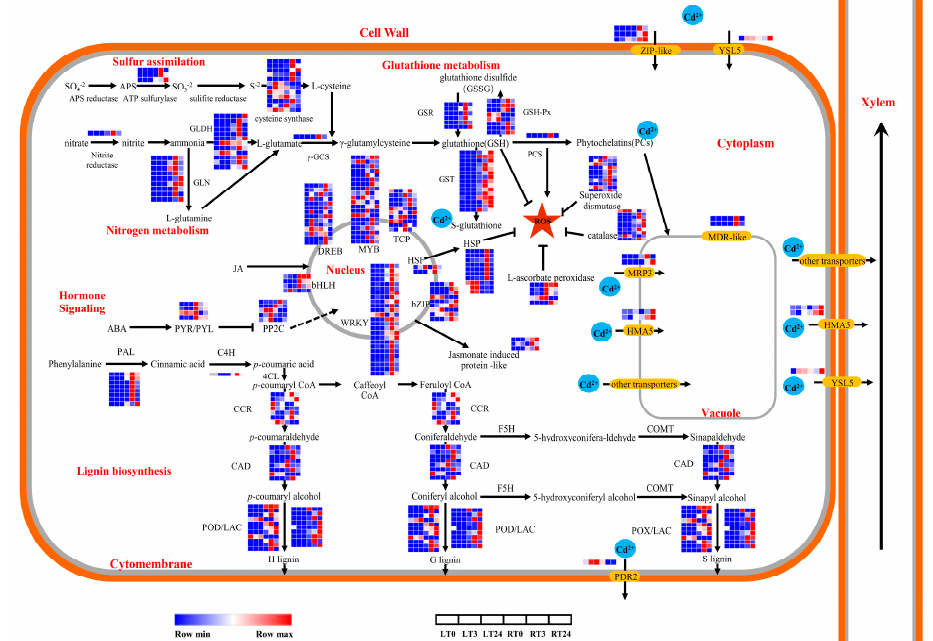
Figure 7. Transcriptional changes of genes responsible for Cd responses in leaves and roots of king grass. The expression heatmaps from left to right were arranged in the following order: leaves—0 h (LT0), leaves—3 h (LT3), leaves—24 h (LT24), roots—0 h (RT0), roots—3 h (RT3) and roots—24 h (RT24).